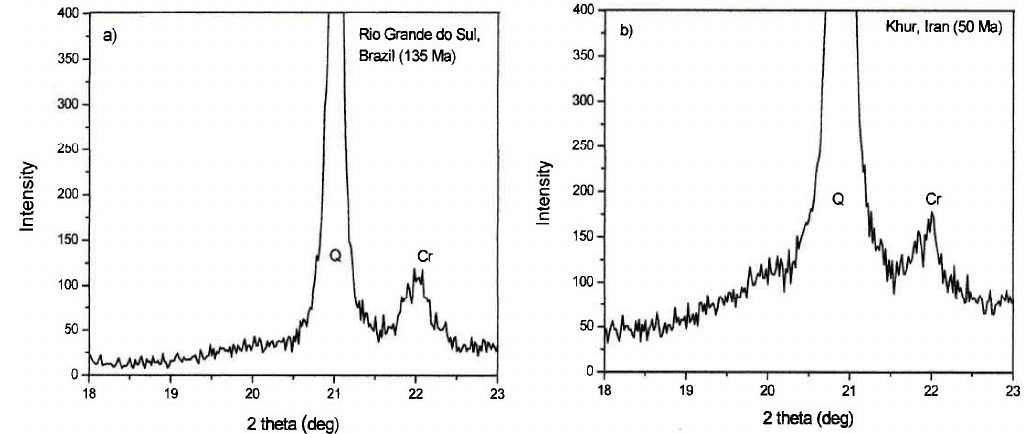
Figure 13. Cristobalite (Cr) identified in agates from Brazil ( a ) and Iran ( b ). The stated ages are the host ages but the properties of Brazilian agate suggest an agate age of 25–30 Ma.